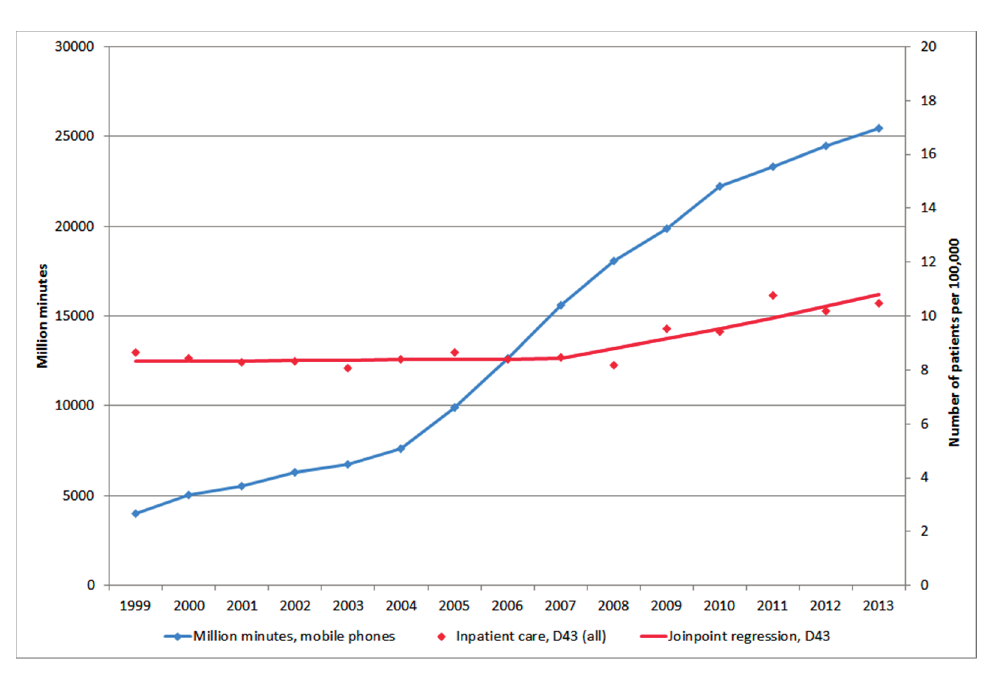
Figure 5. Number of out-going mobile phone minutes in millions during 1999–2013 [33] and joinpoint regression analysis of number of patients per 100,000 inhabitants according to the Swedish National Inpatient Register for all ages during 1999–2013 diagnosed with D43 = tumour of unknown type in the brain or CNS